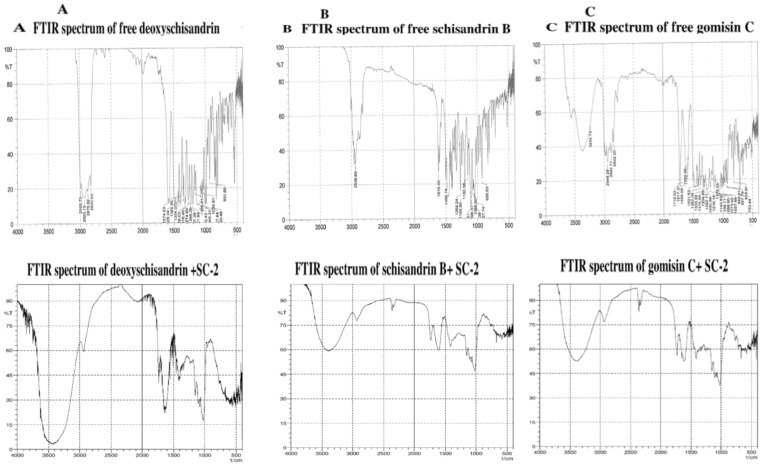
FTIR spectra of the purified free lignans and the lignans+SC-2.Purified free deoxyschisandrin (upper panel) and deoxyschsandrin+SC-2 (lower panel) (A). Purified free schisandrin B (upper panel) and schisandrin B+SC-2 (lower panel) (B). And purified free gomisin C (upper panel) and gomosin C+SC-2 (lower panel) (C). In measuring of the combined IR spectra, equimolar amount of each was used: for deoxyschisandrin+SC-2: 2 mL of deoxyschisandrin solution (1.04 mg/25 mL)+2 mL of SC-2 solution (1 mg/mL). For schisandrin B+SC-2: 2 mL of schisandrin B (4 mg/25 mL)+2 mL of SC-2 (4 mg/mL). And for gomisin C+SC-2: 2 mL of gomisin solution (5.2 mg/25 mL)+2 mL of SC-2 solution (4 mg/mL) were used. The mixture was respectively mixed thoroughly with KBr (IR grade) (in 1∶100 w/w), dried at 40°C under vacuum for 16 h, fabricated into KBr tablets and subjected to FTIR scanning using Shimadzu FTIR 460 (Shimadzu, Tokyo, Japan). Each sample was repeatedly scanned for at least 10 times to assure the precision of the data.